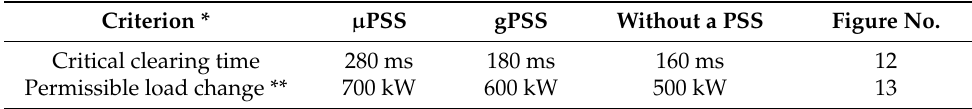
Table 7. The effects on the transient